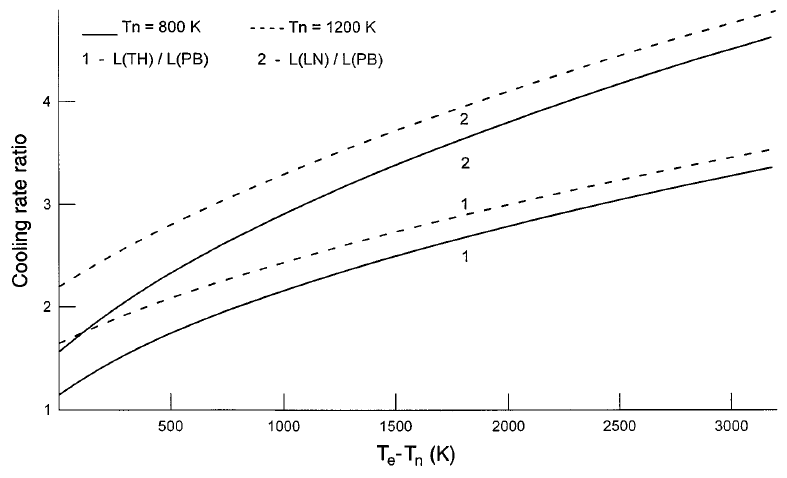
Fig. 2. Ratios of the fine structure cooling rate calculated by the use of the e(cid:128)ective collision strengths of Tambe and Henry (1974, 1976) ( curves 1 ) and Le Dourneuf and Nesbet (1976) ( curves 2 ) with respect to the new oxygen fine structure cooling rate given by Eqs. (12)–(15) and based on the e(cid:128)ective collision strengths of Bell et al. (1998) for T n (cid:136) 800 K ( solid line ) and T n (cid:136) 1200 K ( dashed line )